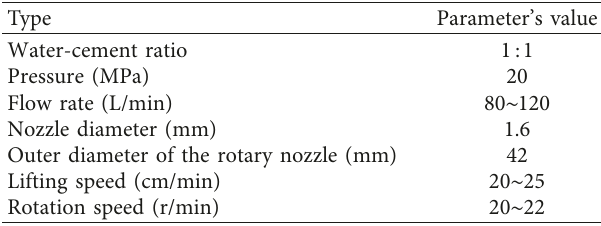
Table 2: Construction technology parameters of single pipe rotary jet grouting.